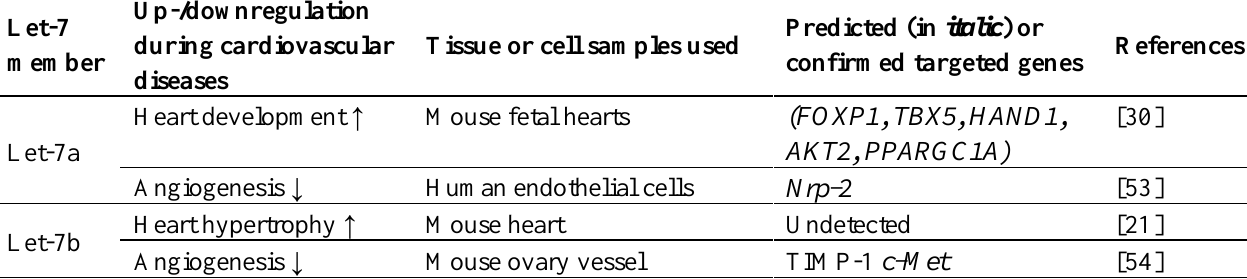
Table 1. Synopsis of let-7 in cardiacvascular diseases, heart development and cardiavascular differentiation from stem